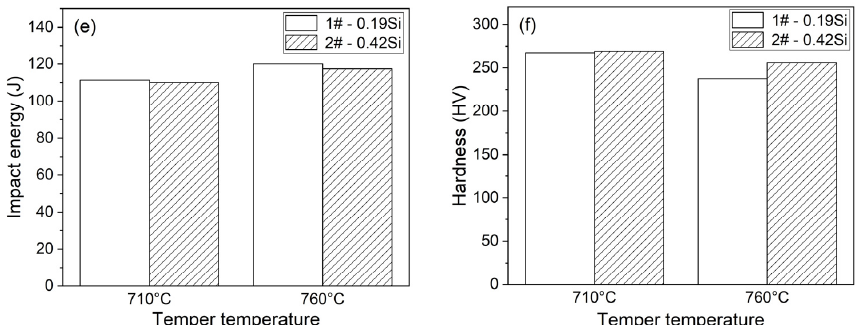
Figure 10. Effects of temper temperature and Si content on the mechanical properties of HT-9 steels at room temperature: ( a ) yield strength, ( b ) ultimate tensile strength, ( c ) reduction of area, ( d ) elongation, ( e ) impact energy, and ( f ) hardness.